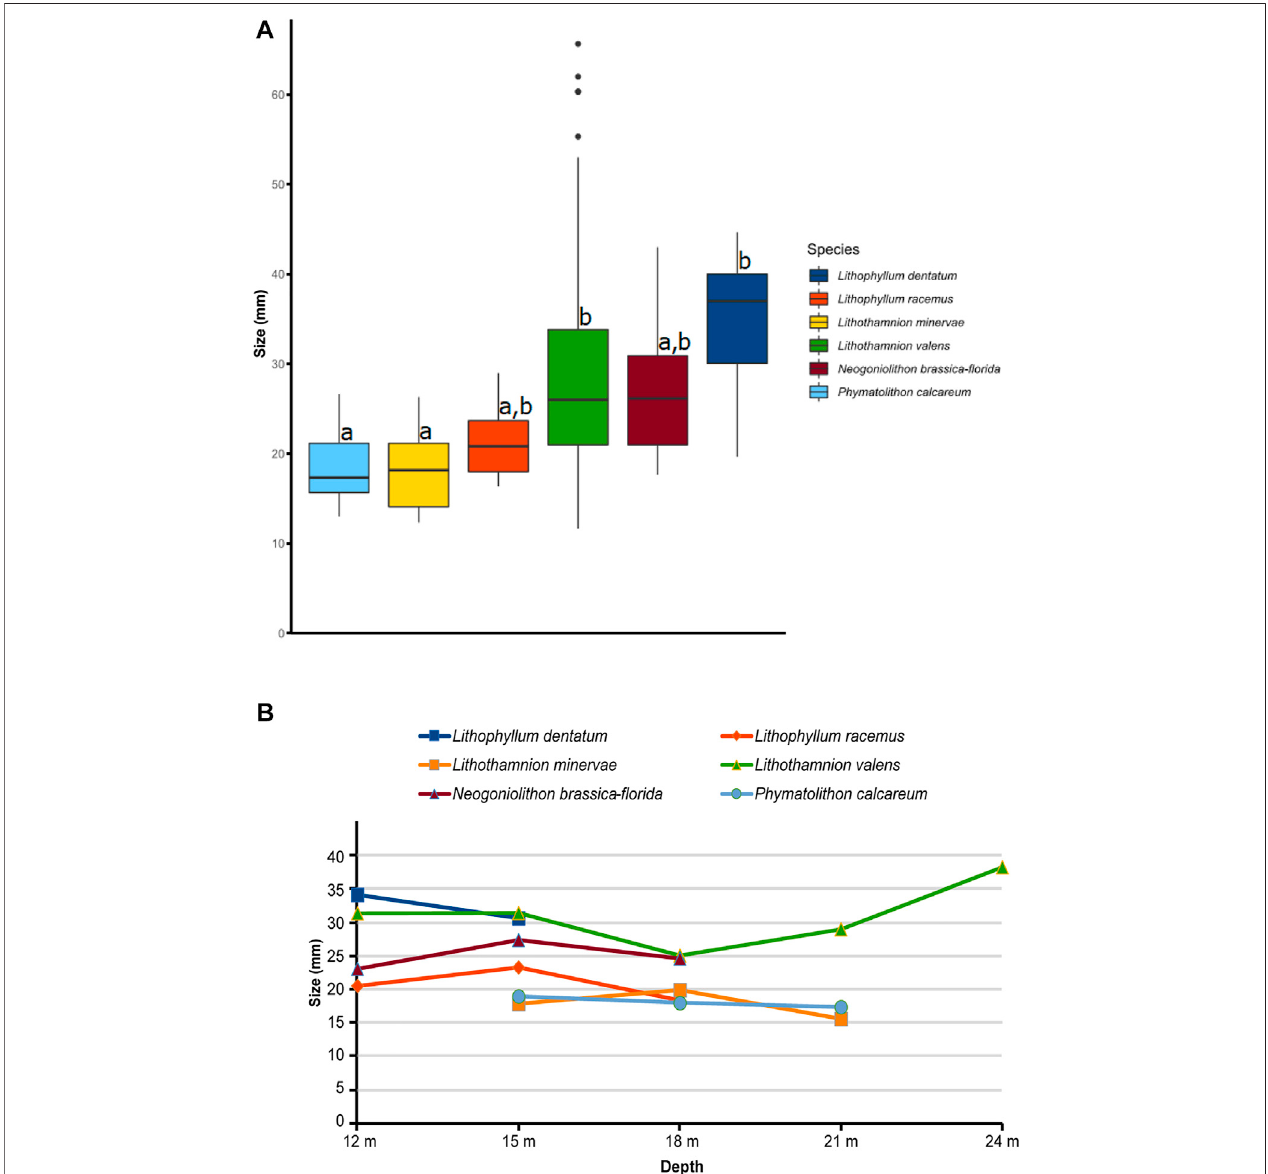
FIGURE11|(A) Boxplots ofsizesofmonospeci fi crhodoliths illustratingsigni fi cantdifferencesdetected acrossspeciesand (B) theirmeansizeatdifferentdepths.